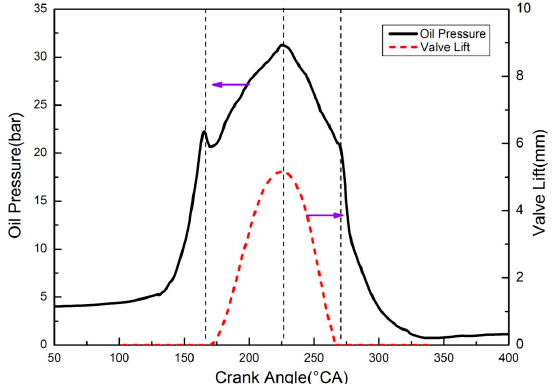
Figure 8. The relationship between valve lift and oil pressure.